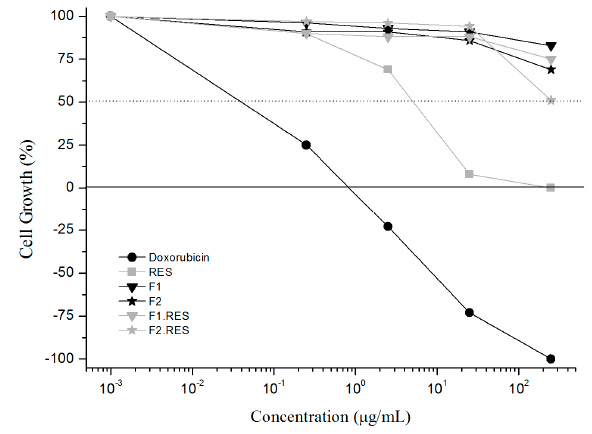
Figure 5. Percentage of cell growth after treatment with positive control (doxorubicin), RES or SLNs.